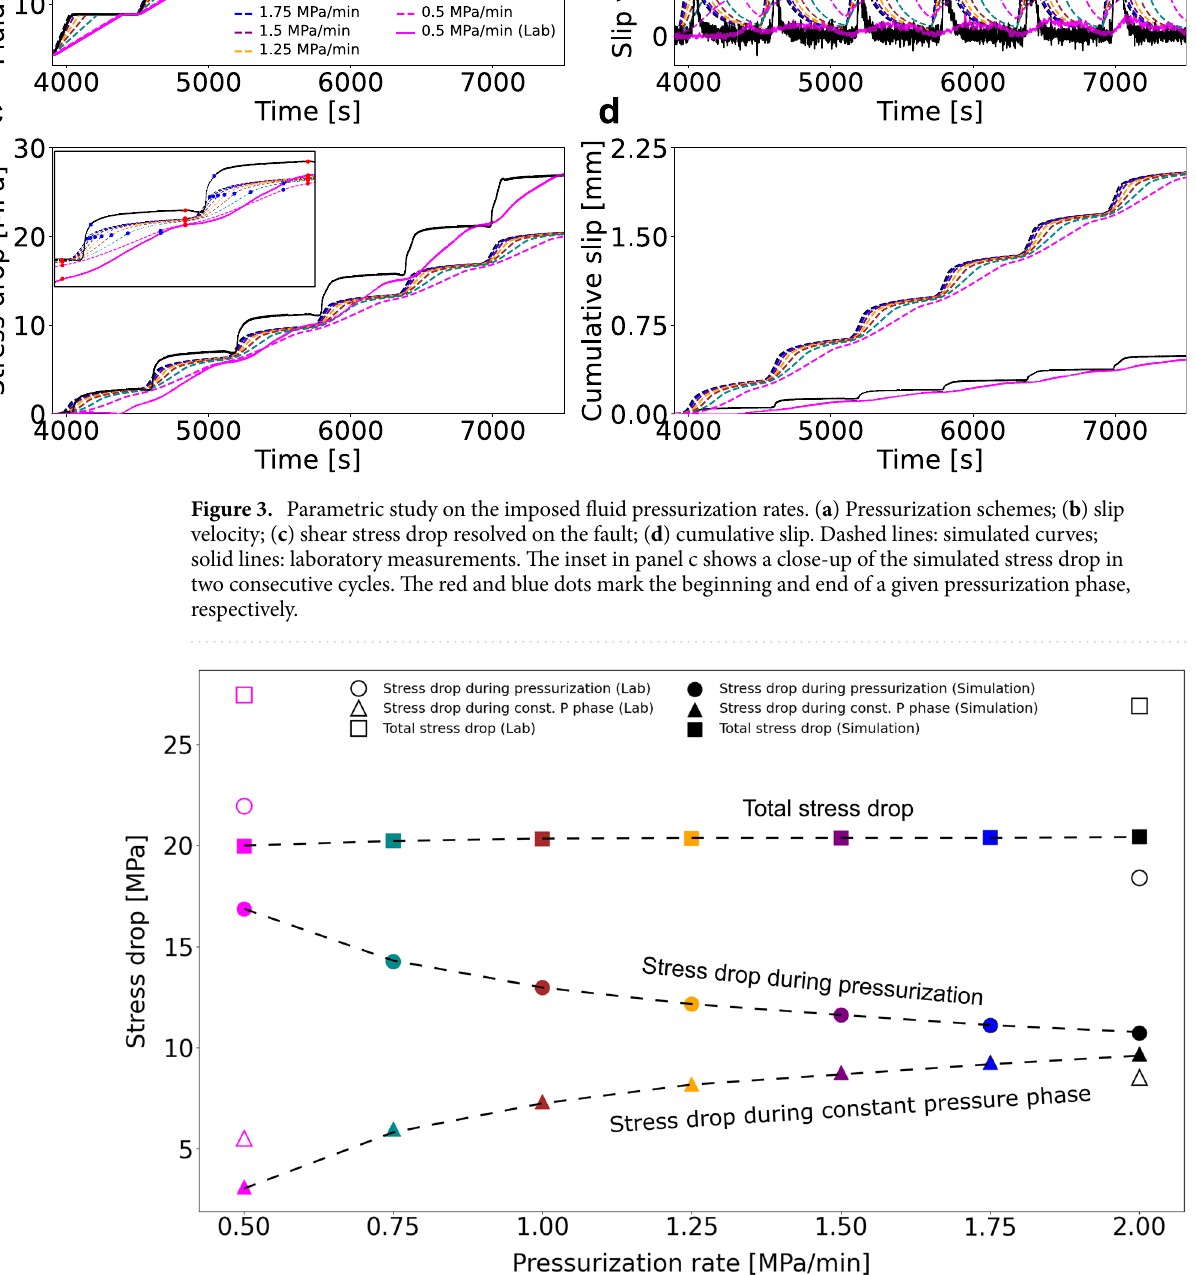
Figure 4. The computed effect (solid symbols) of the applied pressurization rate on the shear stress drop summed over each pressurization phase (circles), over each constant pressure phase (triangles); and the total stress drop (squares). Laboratory values are represented by open symbols. The colours represent different pressurization rates and remain the same as in Fig.